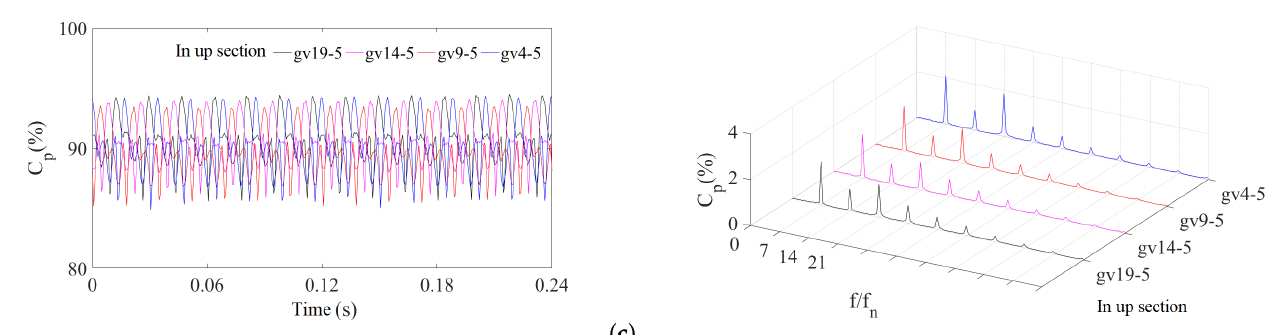
Figure 17. Time–domain and frequency–domain diagrams of pressure fluctuations of the monitoring points along the circumferential direction. ( a ) 60% load condition. ( b ) 86.7% load condition. ( c ) 100% load condition.